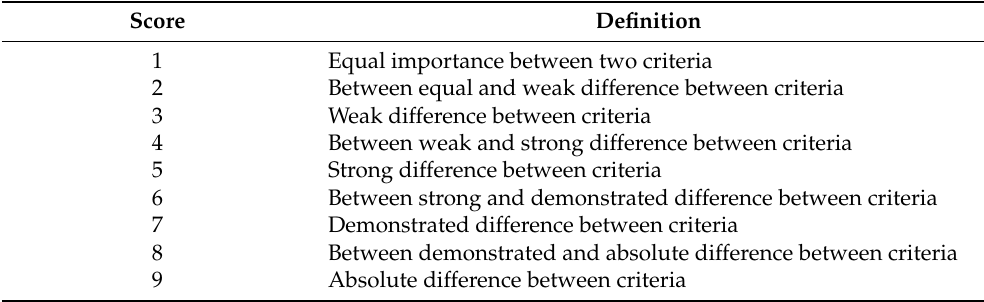
Table 3. Saaty’s fundamental